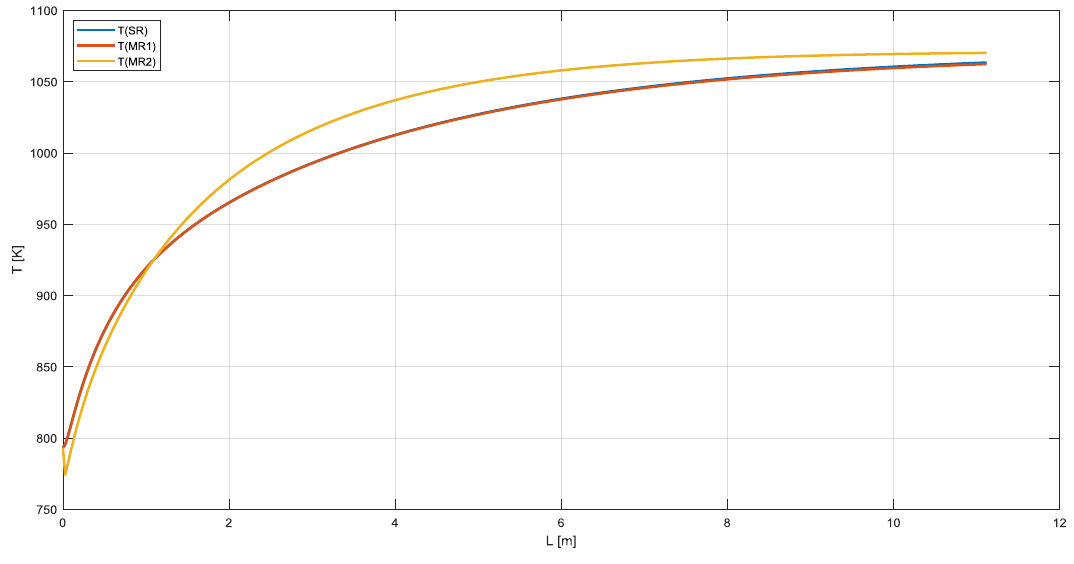
Figure 4. Temperature profile in SR, MR1, and MR2.